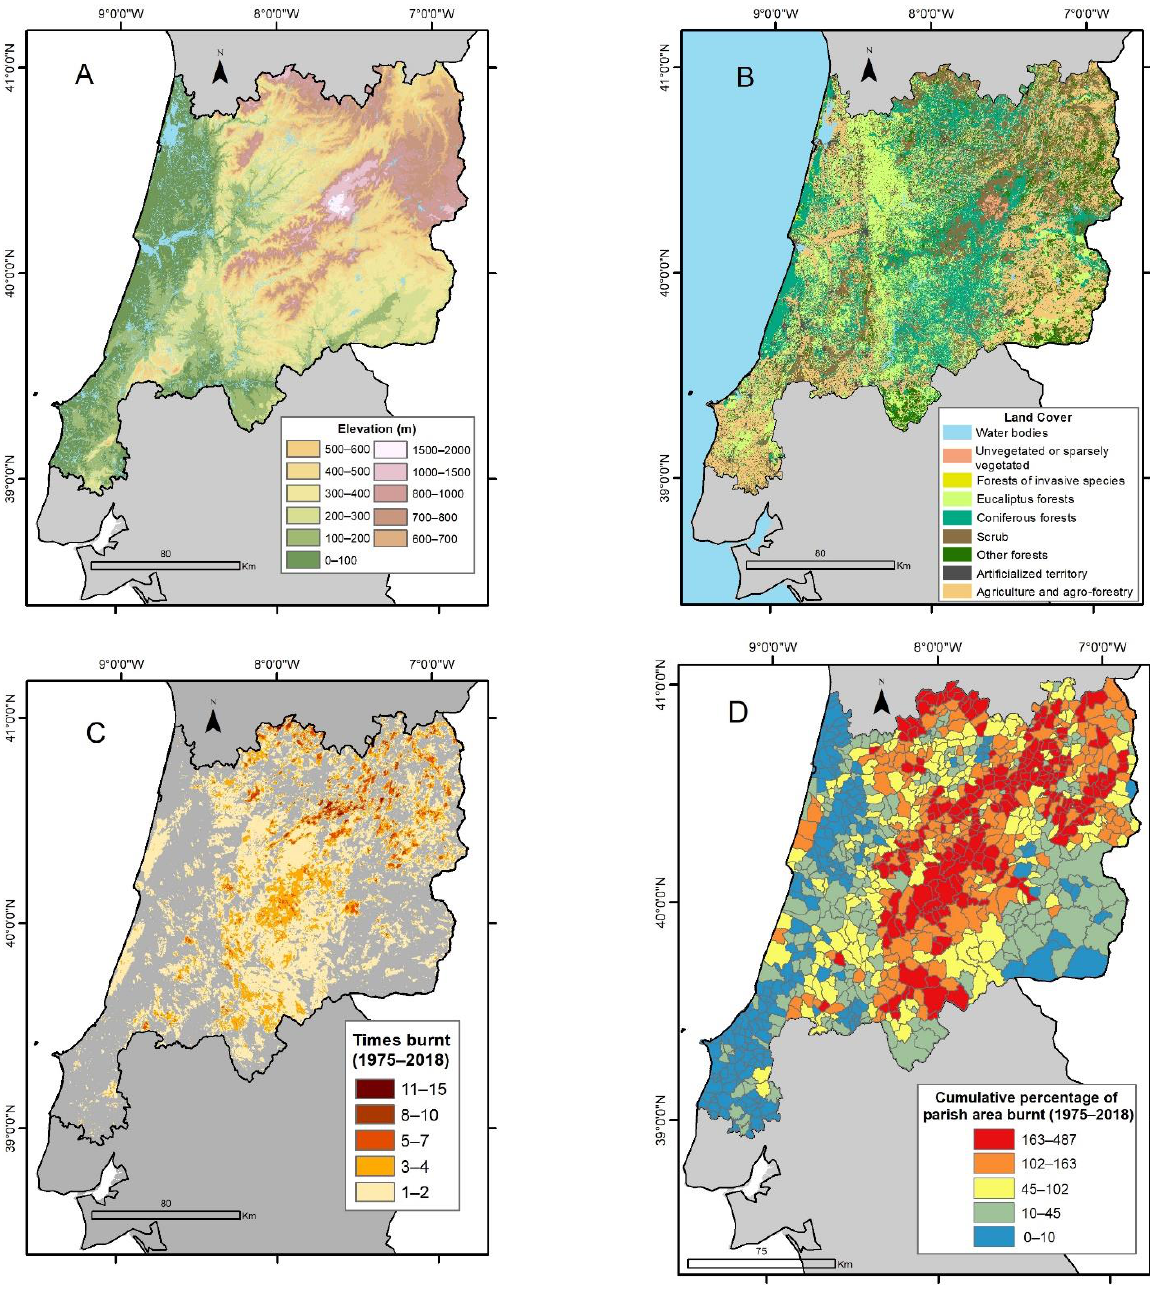
Figure 2. Characteristics of the study area: ( A ) elevation. Source https://www.eea.europa.eu/data-and-maps/data/copernicus-land-monitoring-service-eu-dem (accessed on 1 March 2021); ( B ) land cover. Source: Portuguese General-Directorate of the Territory (Direção-Geral do Território); ( C ) number of times burnt per 25 m pixel between 1975 and 2018; ( D ) cumulative percentage of parish area burnt between 1975 and 2018, classified using quintiles. Source of ( C , D ): Institute for Conservation of Nature and Forests (Instituto da Conservação da Natureza e das Florestas).